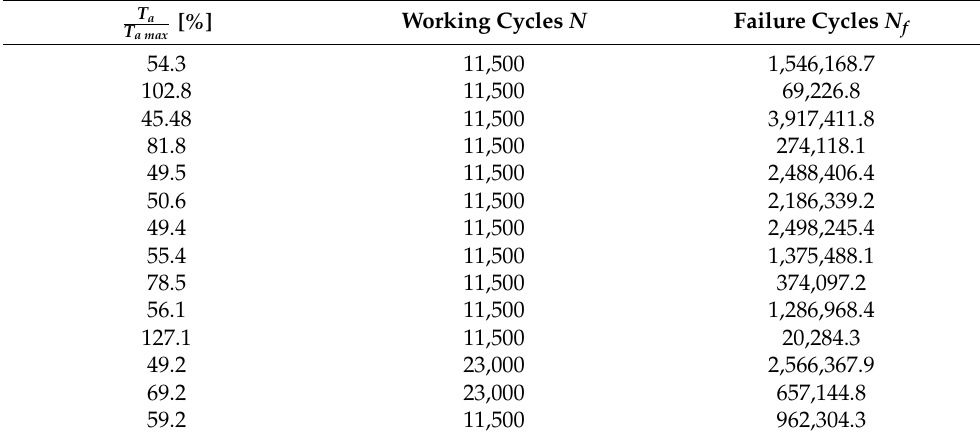
Table 8. Torque amplitude, working cycles and failure cycles for the HEV